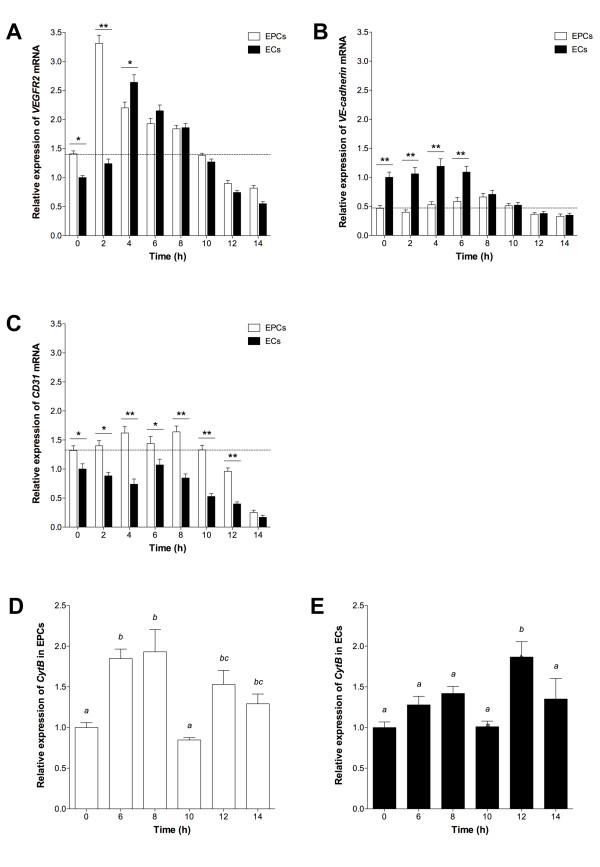
Gene expression during tubule formation. (A) VEGFR2, (B) VE-cadherin and (C) CD31 mean expression in assayed EPCs and ECs, relative to 60% confluent ECs (± SEM; n = 3). Dotted line indicates expression in 60% confluent EPCs. Significant differences between cell types indicated (*P < 0.05, **P < 0.01). CytB expression in (D) EPCs and (E) ECs, relative to 0 h. Columns with different letters are significantly different (P < 0.05).